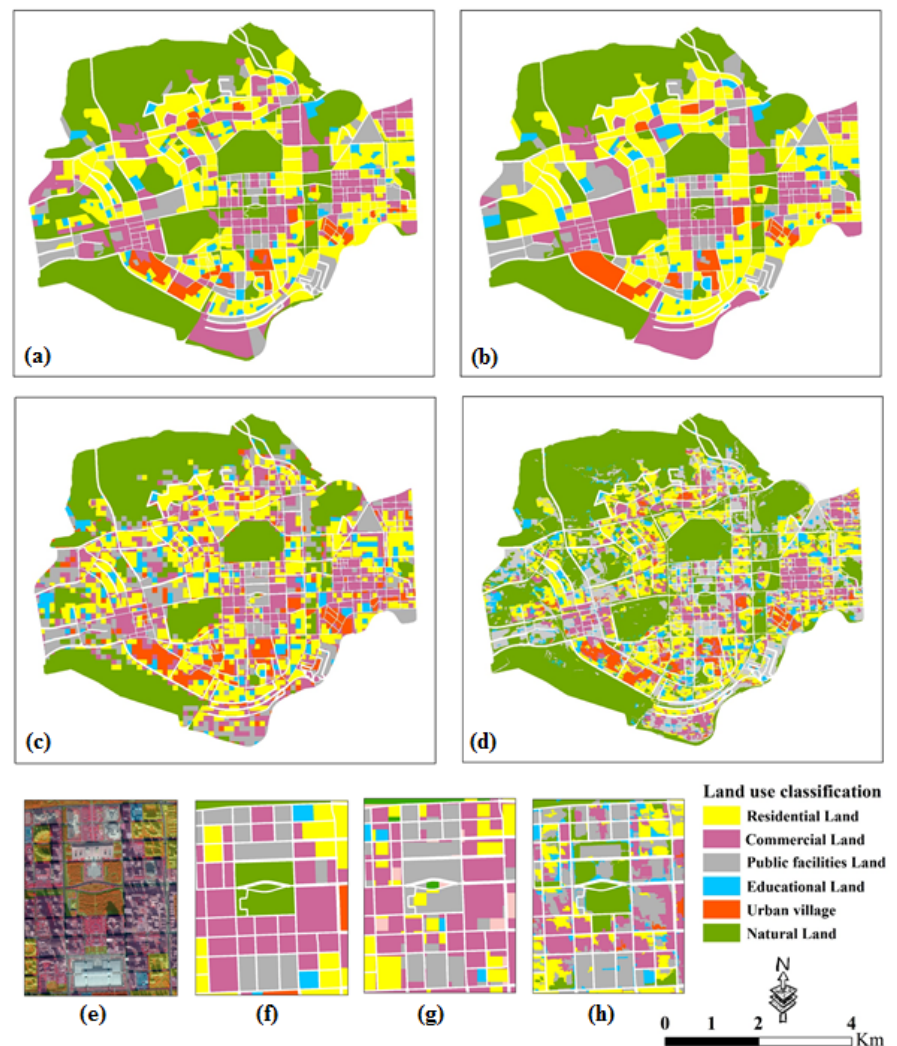
Figure 7. Final classification maps of the Futian district ( a ) the ground-truth map, ( b ) the block level map, ( c ) the grid level map, ( d ) the object level map, ( e ) GF2 image and ground-truth map, ( f – h ) the enlarged areas of ( b – d ), respectively.